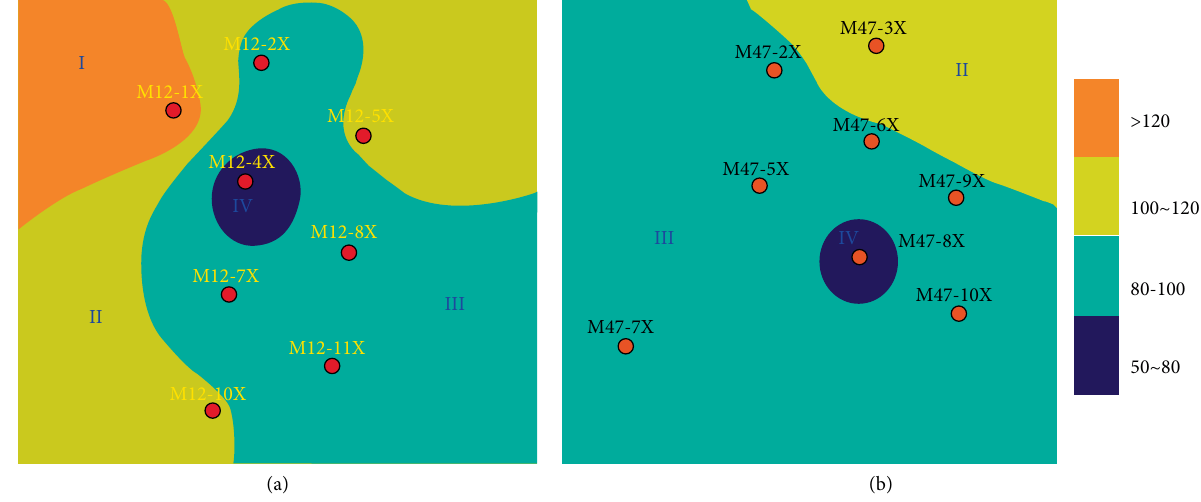
Figure 9: The isogram of the control radius. (a) Study area 1. (b) Study area